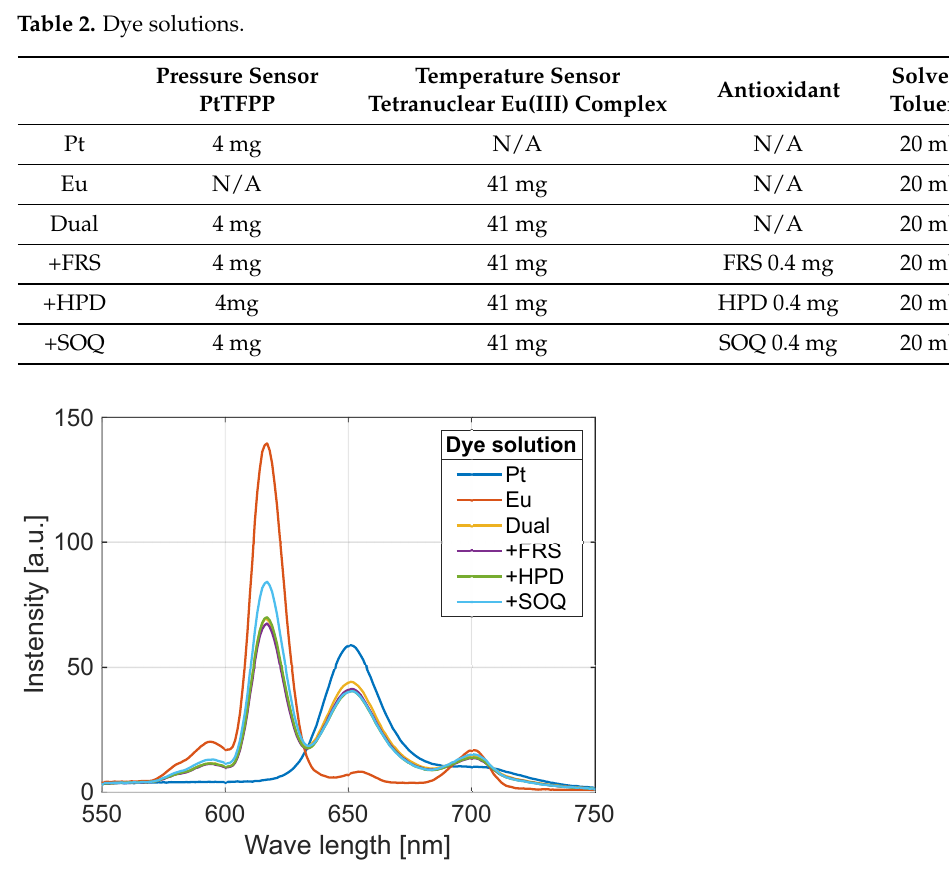
Figure 3. Luminescence spectra at 100 kPa and 20 ◦ C